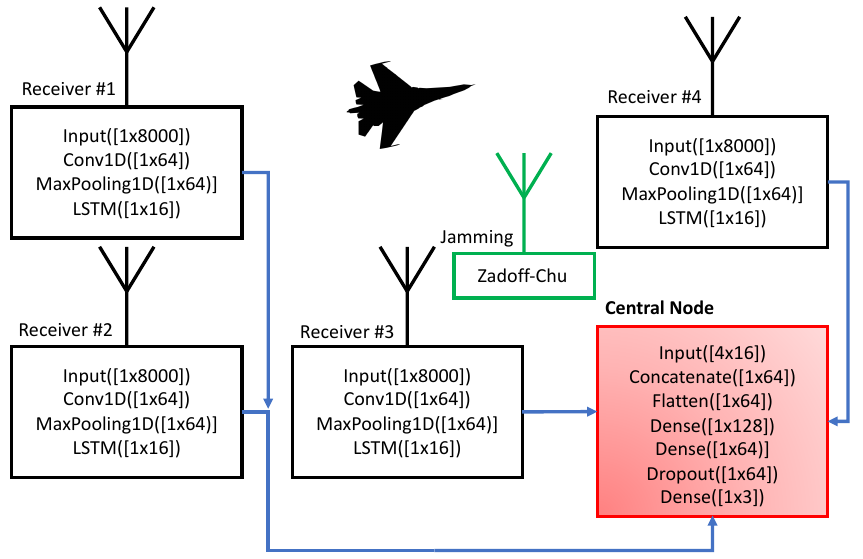
Figure 9. Description of the test-bed. The simulator has four receiving antennas, each connected to a neural network. Then the signals (with major dimension reduction) are concentrated in the central node. The central node is used for delay